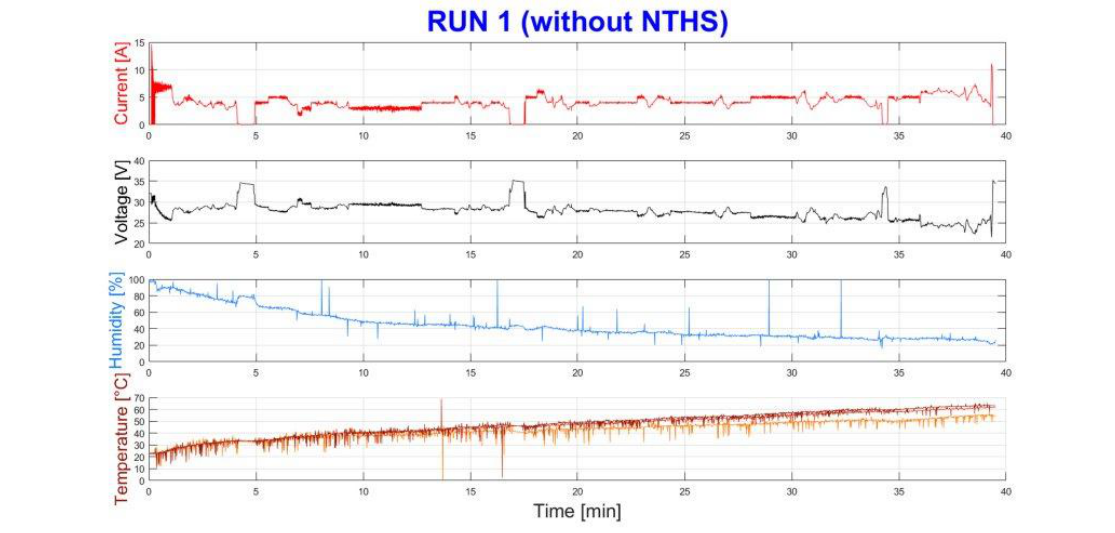
Figure 11. Results during the Run 1 without NTHS.